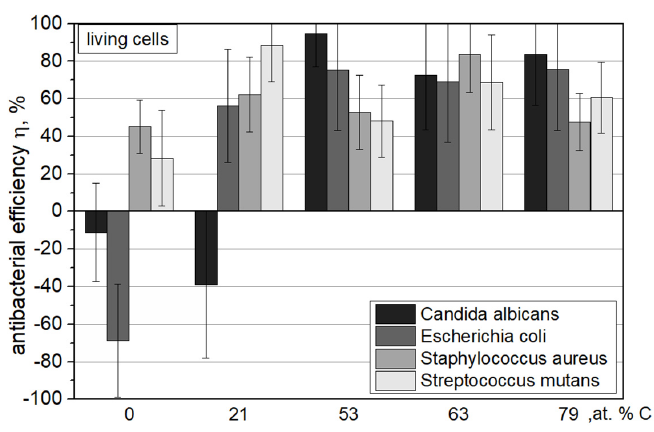
Figure 10. The relative number (cfu/cm 2 ) of living bacterial cells on the Zr–C coated samples relative to the number of living bacterial cells on the uncoated 304L sample.